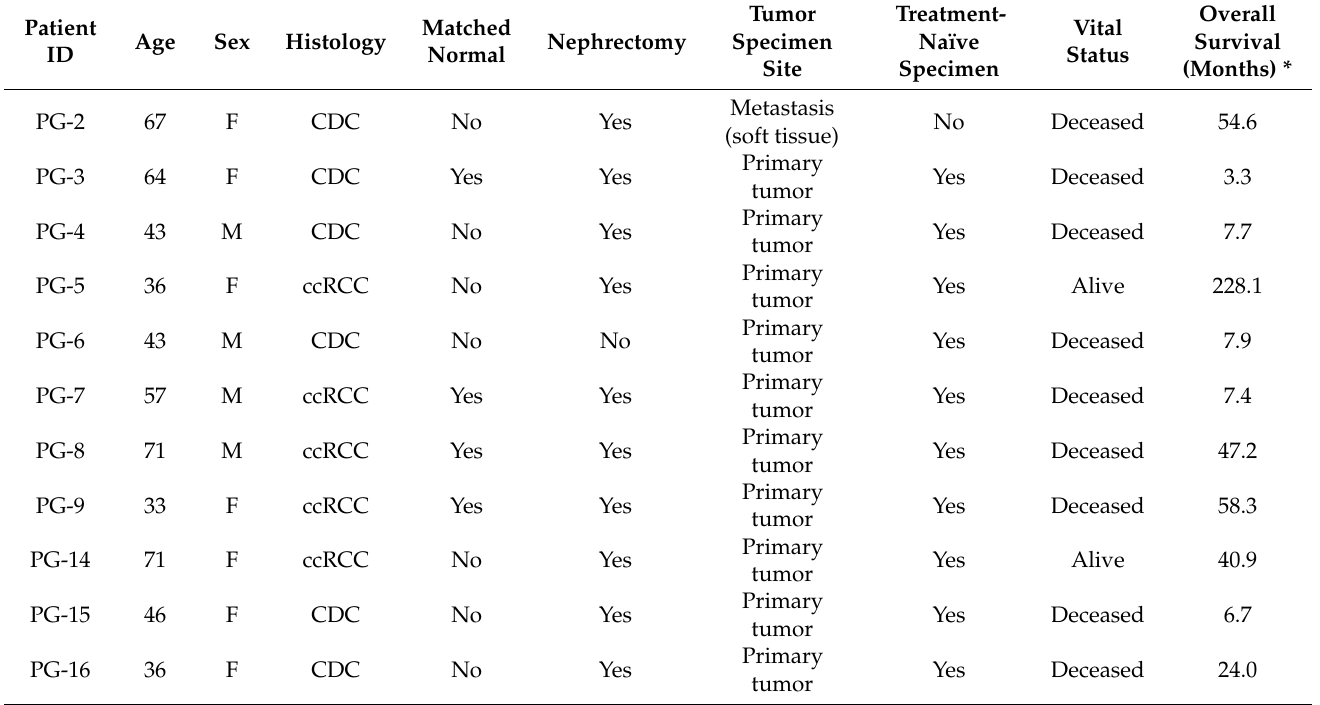
Table 1. Patient characteristics of the INT